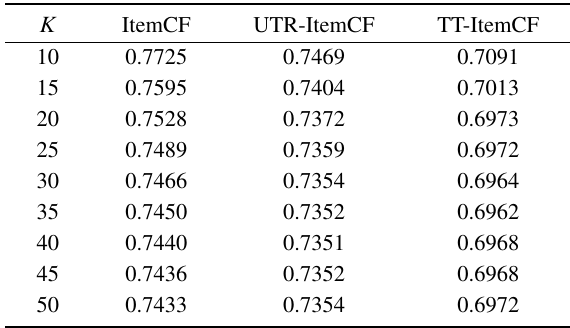
Table 5 MAE values of the UserCF, ItemCF,